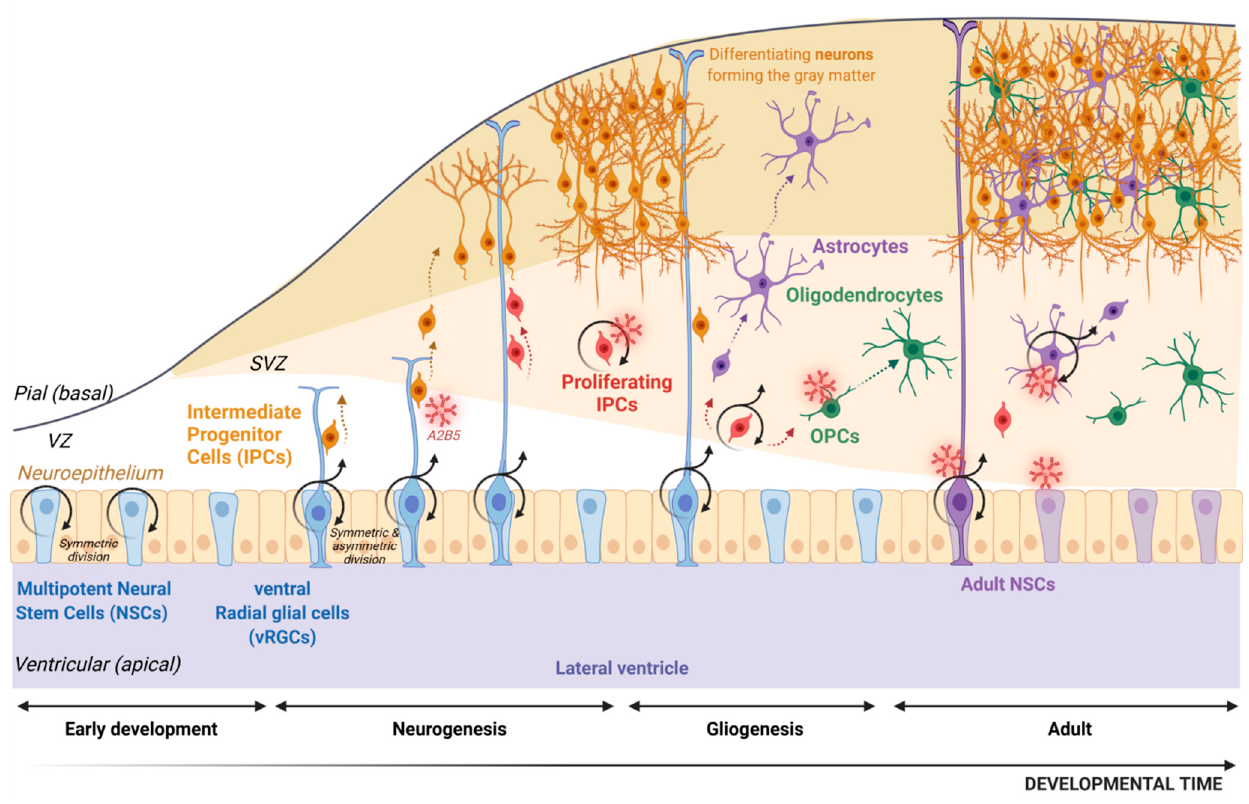
Figure 2. Schematic representation of neurogenesis and gliogenesis processes during development and in adulthood.